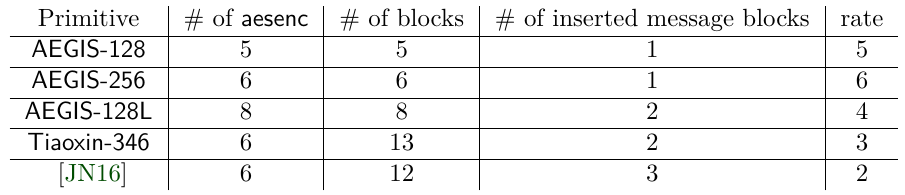
Table 3: Round functions of AEGIS family and Tiaoxin-346